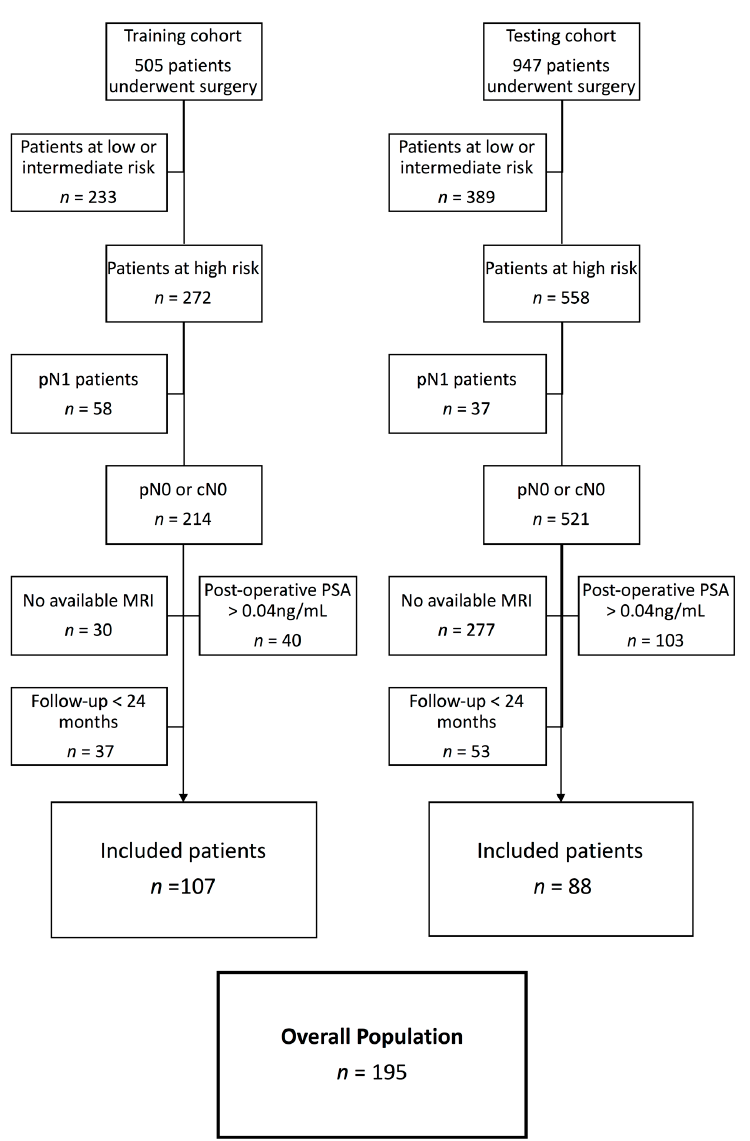
Figure 1. Flowchart of the selection. Abbreviations: pN1: lymph node involvement